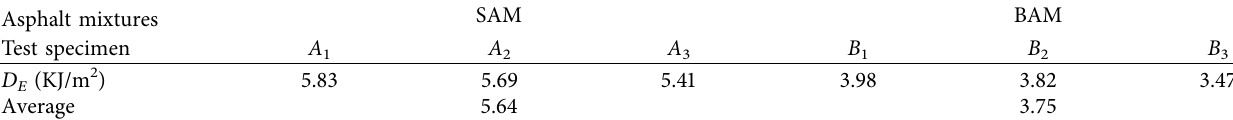
Table 7: Horizontal strain energy density D